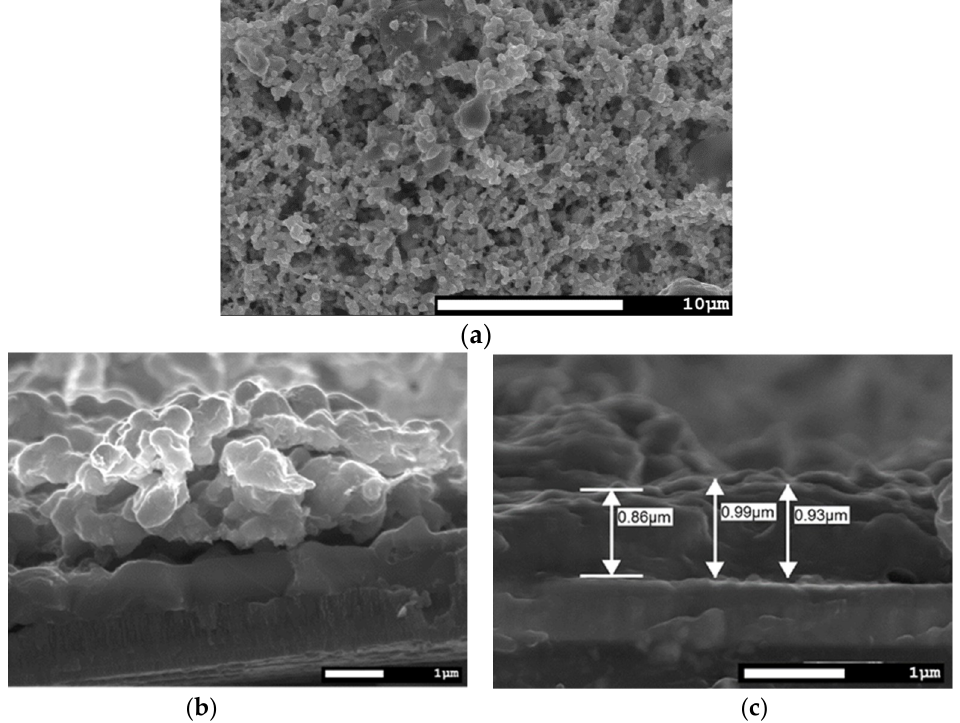
Figure 5. SEM images of a CISe‐film from Cu‐In + Se nanoparticle precursor with a sputter‐deposited seeding layer after face‐to‐face annealing at 550 °C for 5 min with 46.1 kN/m² pressure. ( a ) Top view image comparable to route Ia. ( b ) Cross‐section image shows a dense CISe film from the seeding layer and on top a ca. 2.5 µm thick coarse grained CISe film. ( c ) Cross‐section close up of dense CISe film from the sputtered seeding layer with ca. 1 µm thickness.